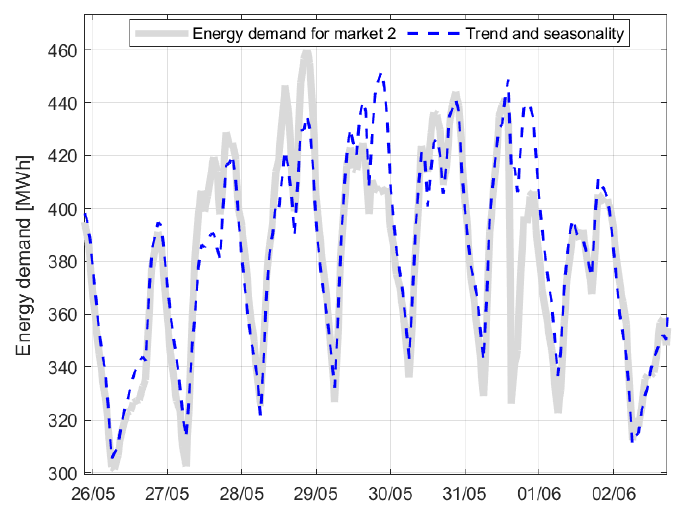
Figure 4. Daily energy demand for Market 2 in the period between 26 May 2018 – 2 June 2018.